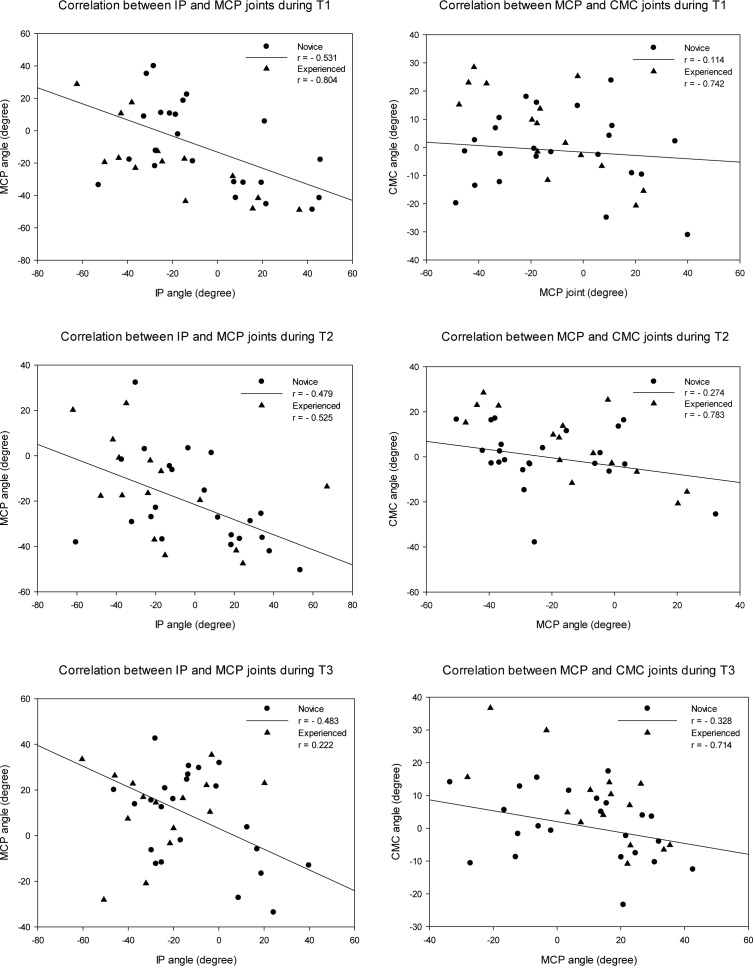
Correlations of the thumb IP and MCP joints as well as the MCP and CMC joints while performing three PA glide techniques with maximum effort in both groups.The positive angle indicates flexion, and the negative angle indicates extension.